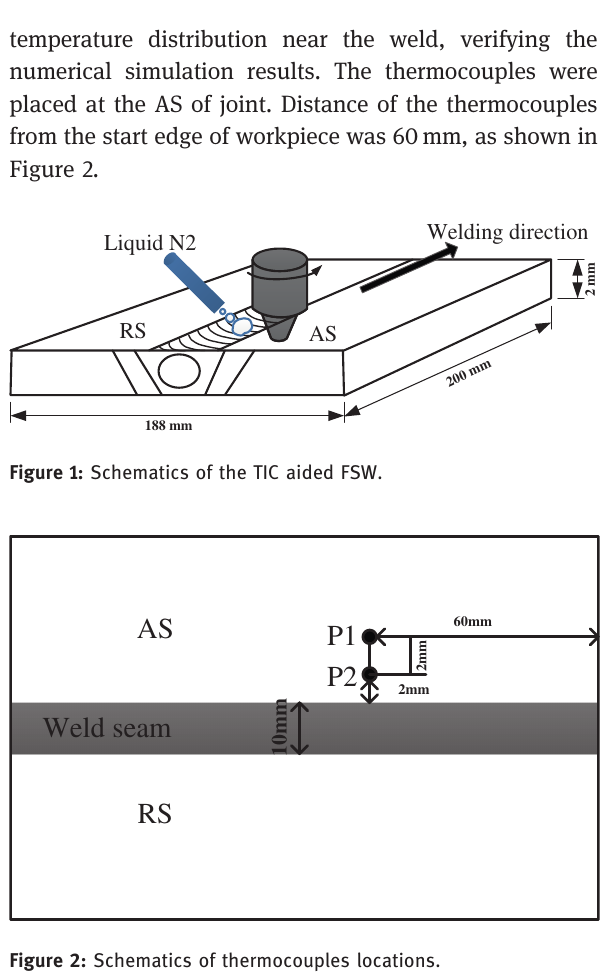
Figure 2: Schematics of thermocouples